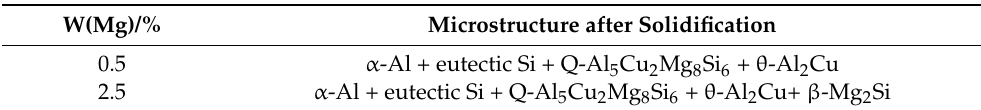
Figure 5. Solidification paths of Al − 17Si − 4Cu − xMg alloys. Table 3. The microstructure of the alloy after solidification corresponding to different Mg content calculated by the Scheil